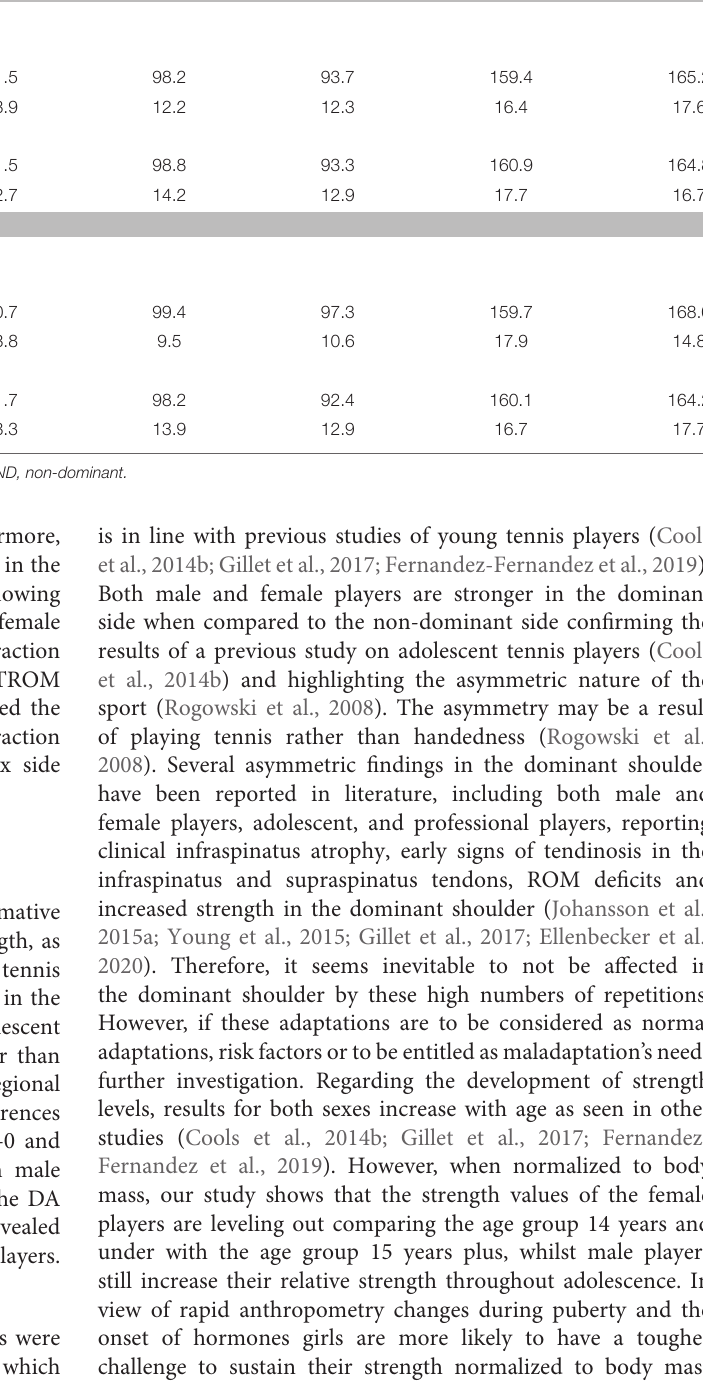
ROM IR ROM ER Total